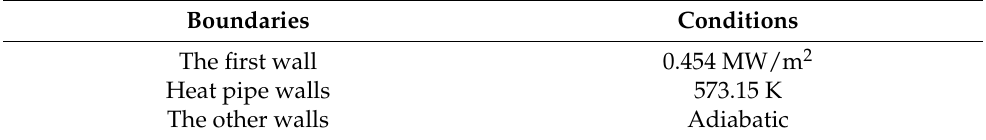
Table 3. Boundary